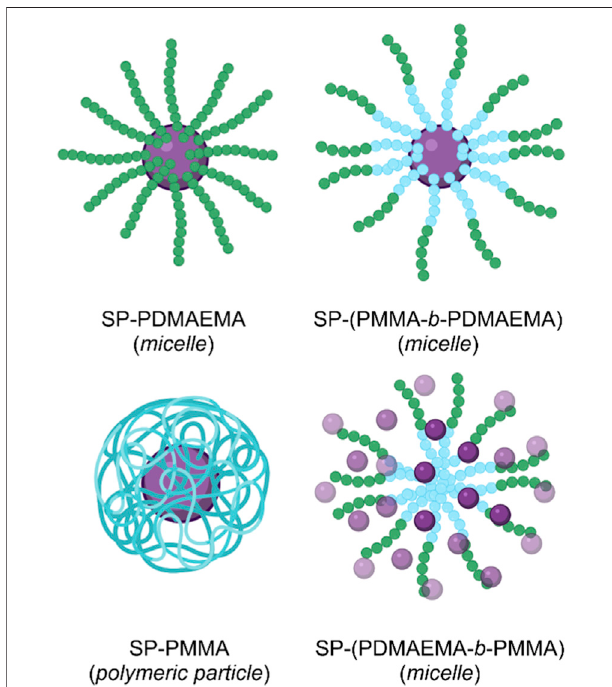
FIGURE 9 | The four micellar and polymeric NPs assembled from the PMMA (blue) and PDMAEMA (green) block copolymers, with terminal SP (purple) groups (Razavi et al., 2020). Figure adapted with permission from Frontiers under a CC BY 4.0 license (Fagan et al., 2021).